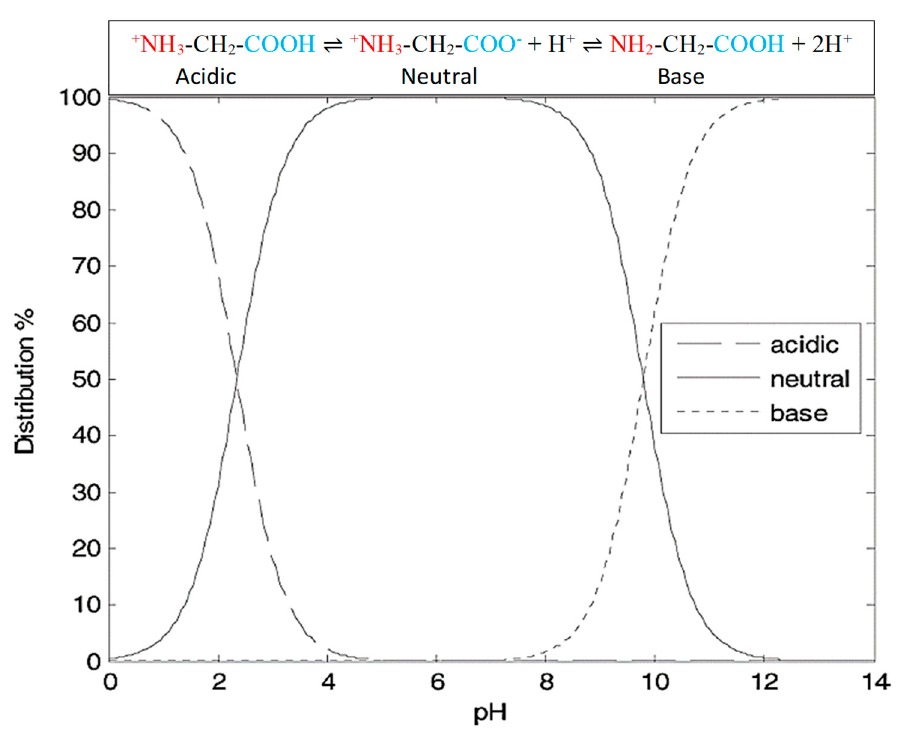
Figure 6. Change in chemical forms of amino and carboxyl groups of glycine between the pH ranges of 0 to 14 at 25 ◦ C (reproduced with permission from Guo et al. [84], published by American Chemical Society (2013)).